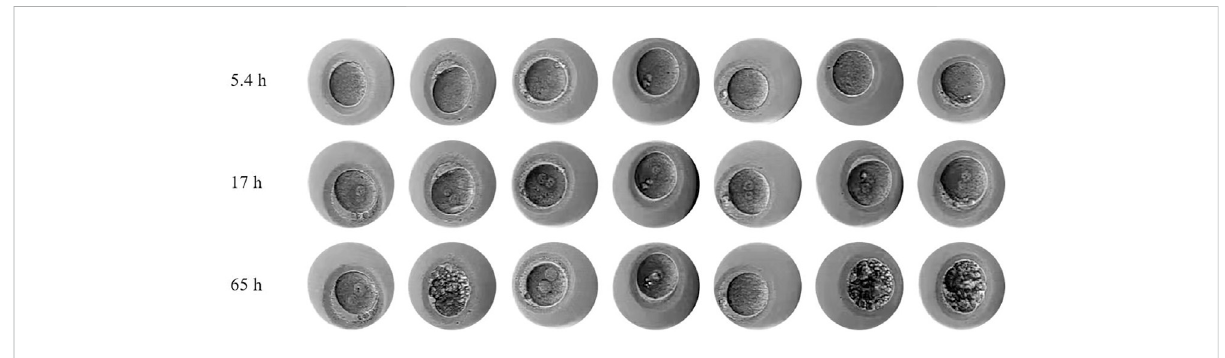
FIGURE 1 Morphological characteristics of seven embryonic observed by time-lapse imaging.